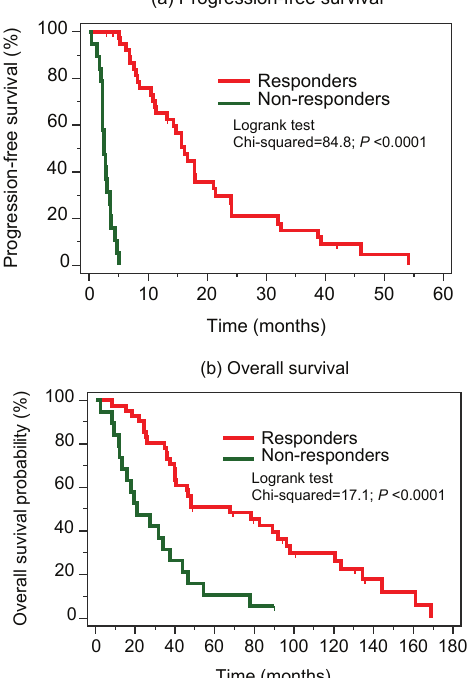
Figure 2. Kaplan-Meier curves in mRCC patients under first-line TKI therapy. ( a ) Progression-free survival. ( b ) Overall survival. Patients were classified as non-responders ( n = 19) and responders ( n = 41) as shown in Table 1 and explained in the text. The log-rank test was used to confirm significant differences between the survival probabilities. Abbreviations: mRCC, metastatic renal cell carcinoma; TKI, tyrosine kinase